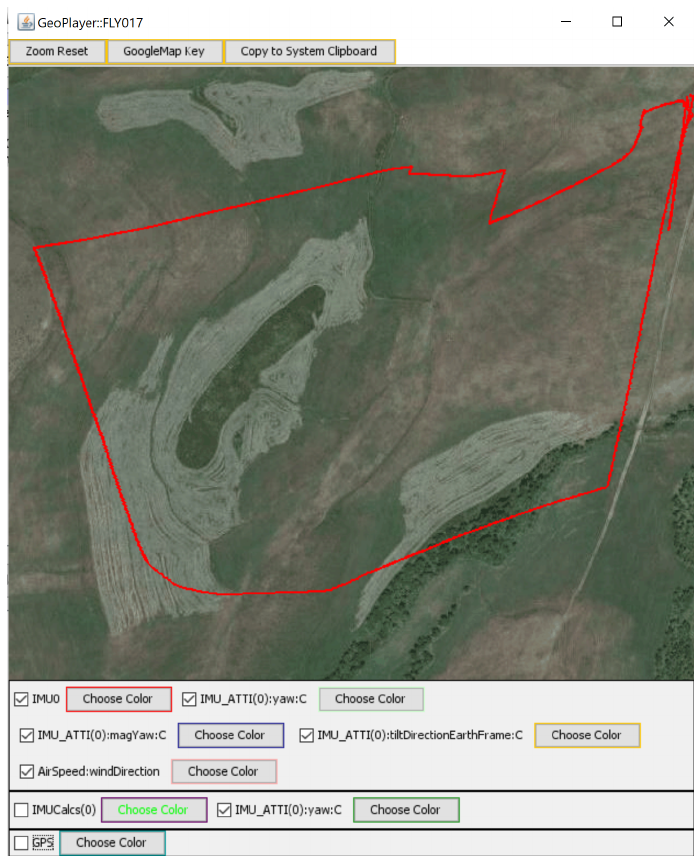
Figure 7. A visual representation of the flight route using the